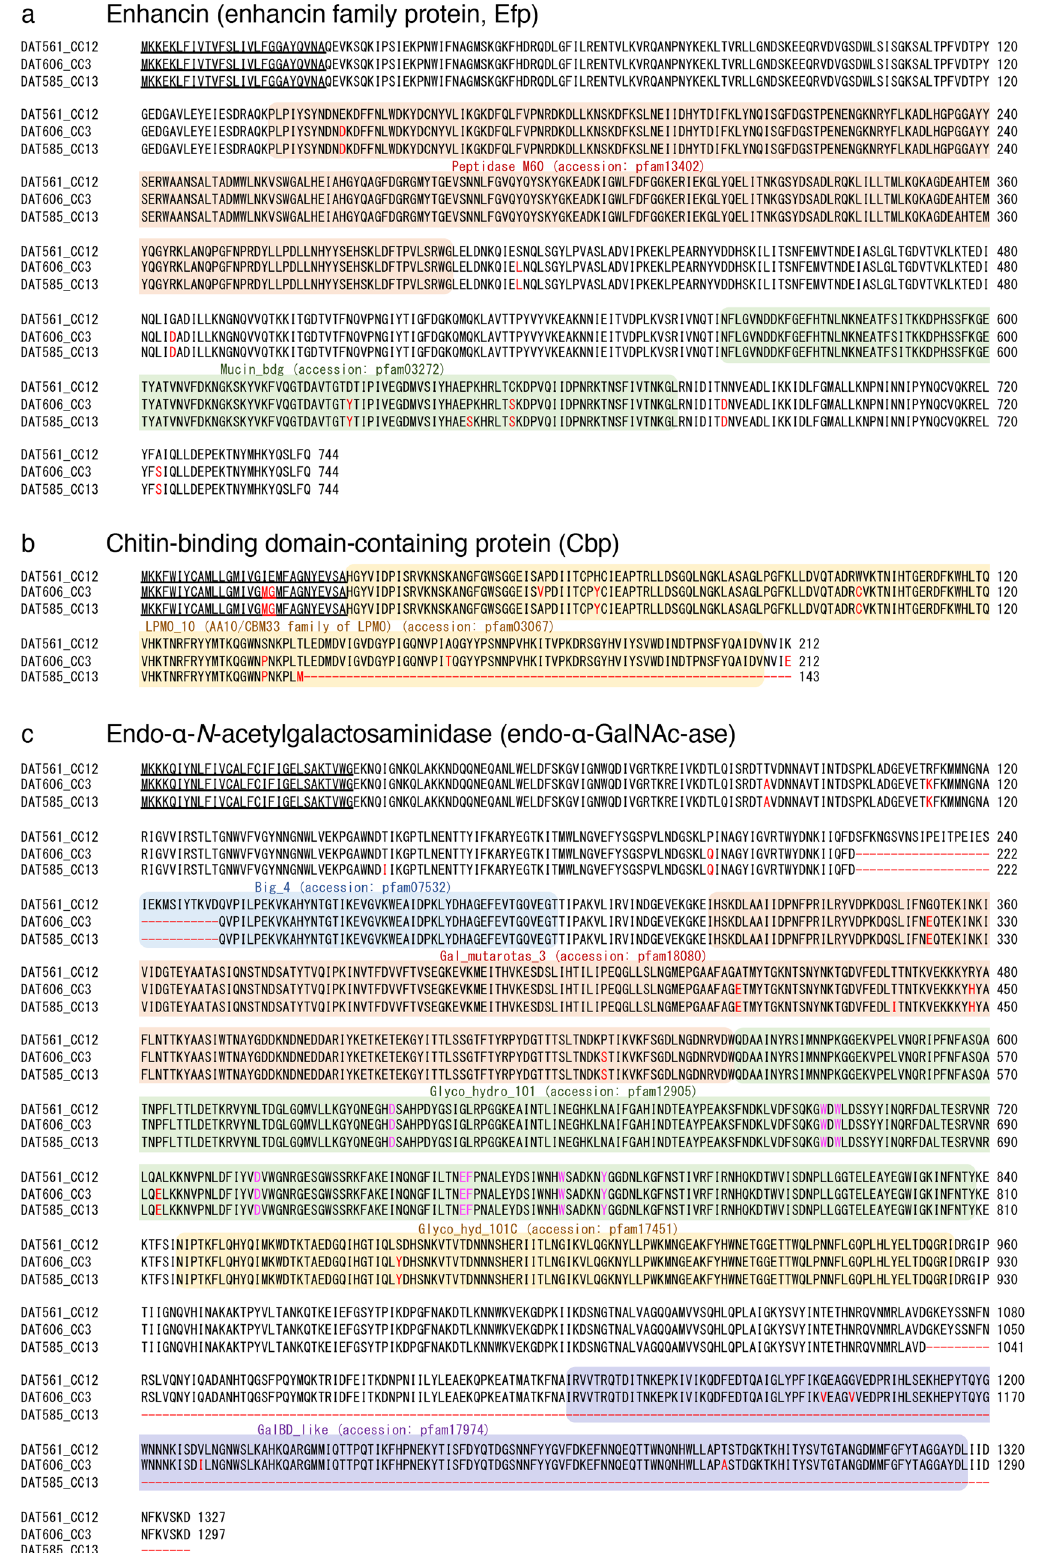
Figure 1. Multiple sequence alignment of enhancin ( a ), chitin-binding domain-containing protein ( b ) and endo-α- N - acetylgalactosaminidase ( c ) of M. plutonius DAT561 (CC12), DAT606 (CC3) and DAT585 (CC13). The multiple alignment was computed using ClustalW (https:// clust alw. ddbj. nig. ac. jp/). Conserved domains are highlighted with colored backgrounds. Red letters represent amino acid residues different from those of DAT561. Hyphens indicate deleted/truncated regions in DAT606 and DAT585. Magenta letters in the endo-α- N -acetylgalactosaminidases are putative catalytic/active sites. Underlined sequences are putative signal peptides predicted by SignalP-5.0 (http:// www. cbs. dtu. dk/ servi ces/ Signa